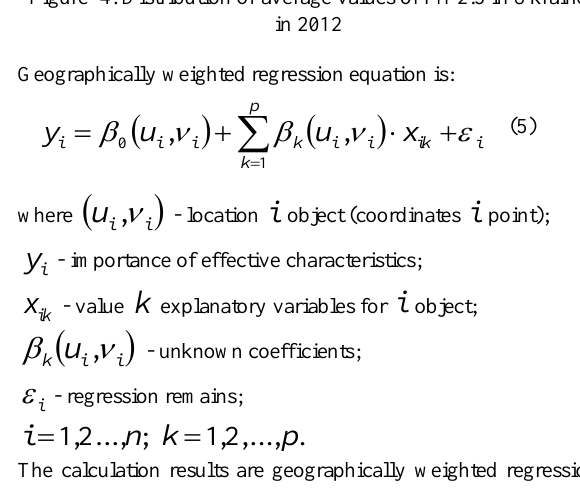
Figure 4. Distribution of average values of PM2.5 in Ukraine in 2012